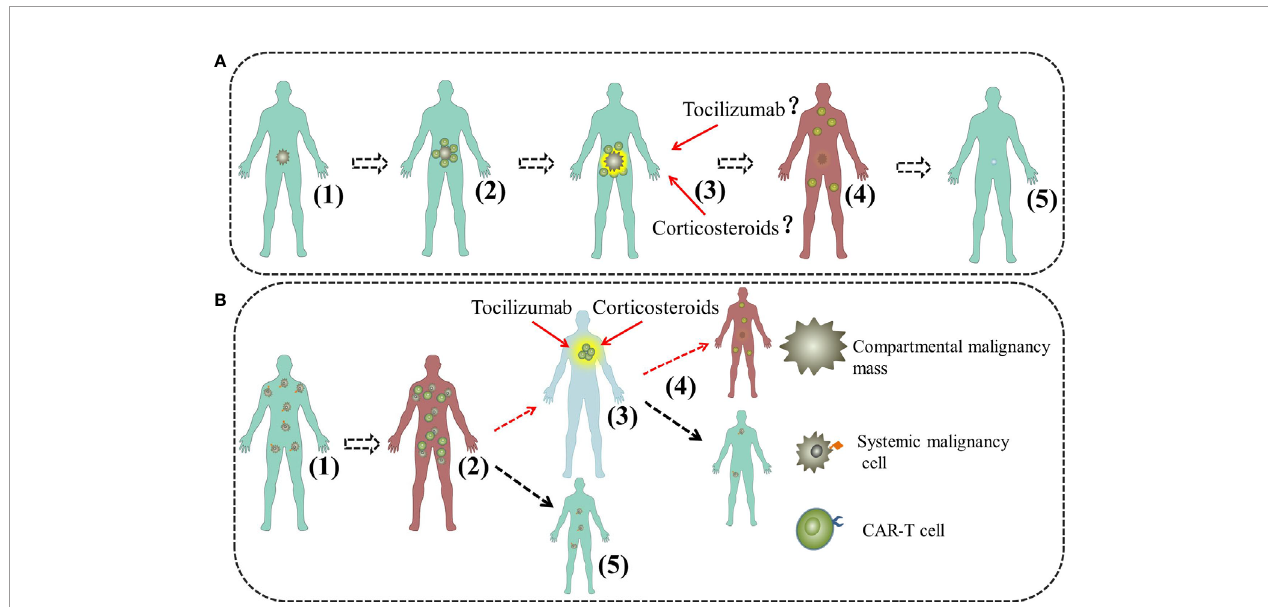
FIGURE 3 | The model of L-CRS for compartmental and systemic malignancies. (A) The model of L-CRS for compartmental malignancies. (1) Malignancy cells restricted; (2) First stage, CAR-T cell local expansion; (3) Second stage, CAR-T cell over fl ow and in fl ammatory cytokine surge; (4) Third stage, CAR-T cell redistribution and organ damage; (5) Fourth stage, recovery. (B) The model of L-CRS for systemic malignancies in our case. (1) Malignancy cells diffused. (2) First stage, S-CRS; (3) Second stage, CAR-T cell redistribution and organ damage, possible for L-CRS; (4) Third stage, CRS abatement and recovery, possible for a new cycle of S-CRS; (5) In most case, L-CRS does not happen or just too weak to be identi fi